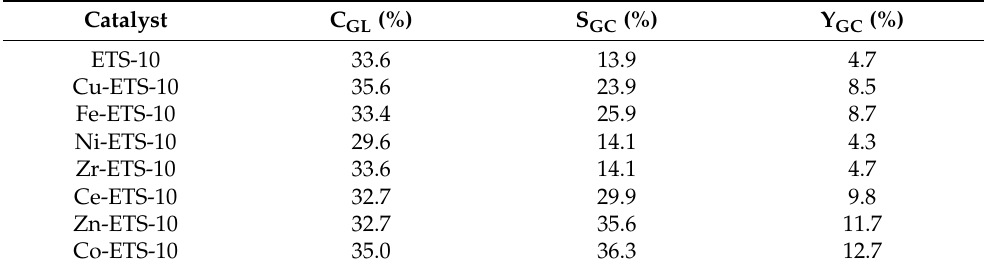
Table 2. Carbonylation of glycerol with CO 2 over different metal-based ETS-10 zeolite catalysts under